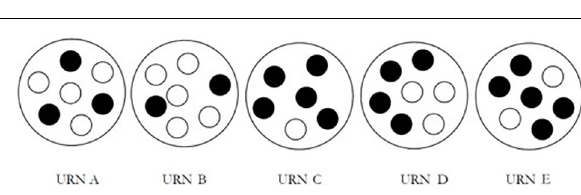
FIGURE 1 | Stimuli as originally reported in the MAT-2.